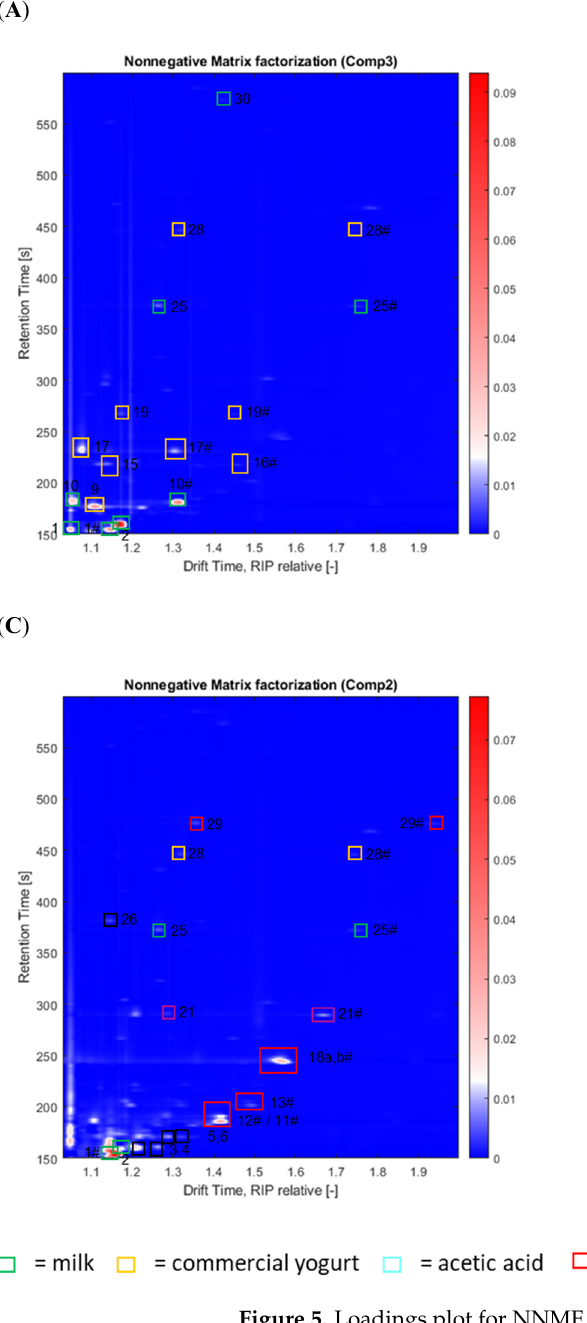
Figure 5. Loadings plot for NNMF analysis with k = 4, showing ( A ) component 3, ( B ) component 4, ( C ) component 2, and ( D ) component 1. Milk-related compounds are marked in green, commercial yogurt in orange, acetic acid in turquoise, yeast-related compounds in red, hexanal in purple, and unknown compounds in black.